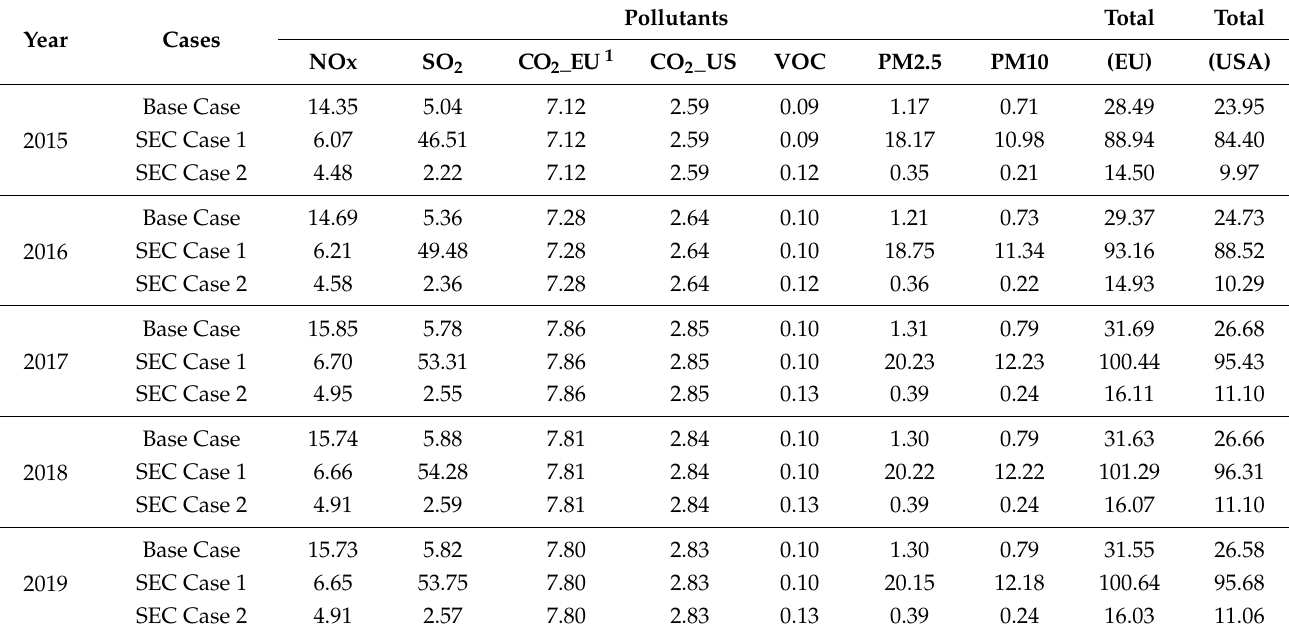
Table 13. Estimated social environmental cost of ship pollutant emissions at Busan Port [USD